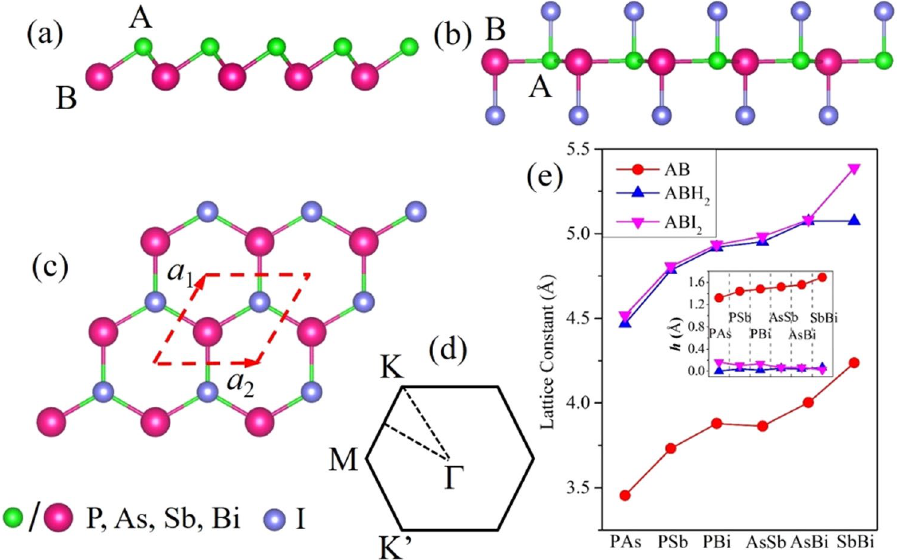
Figure 1. ( a ) Atomic structure of pristine AB monolayers. ( b ) Side view and ( c ) top view of ABI 2 monolayer. ( d ) The corresponding 2D Brillouin zone of ABI 2 monolayer with high-symmetry points. ( e ) Evolution of lattice constant for pristine AB, ABH 2 , ABI 2 monolayers, respectively. The insert stands for the buckled height ( h ) as a function of different configurations.